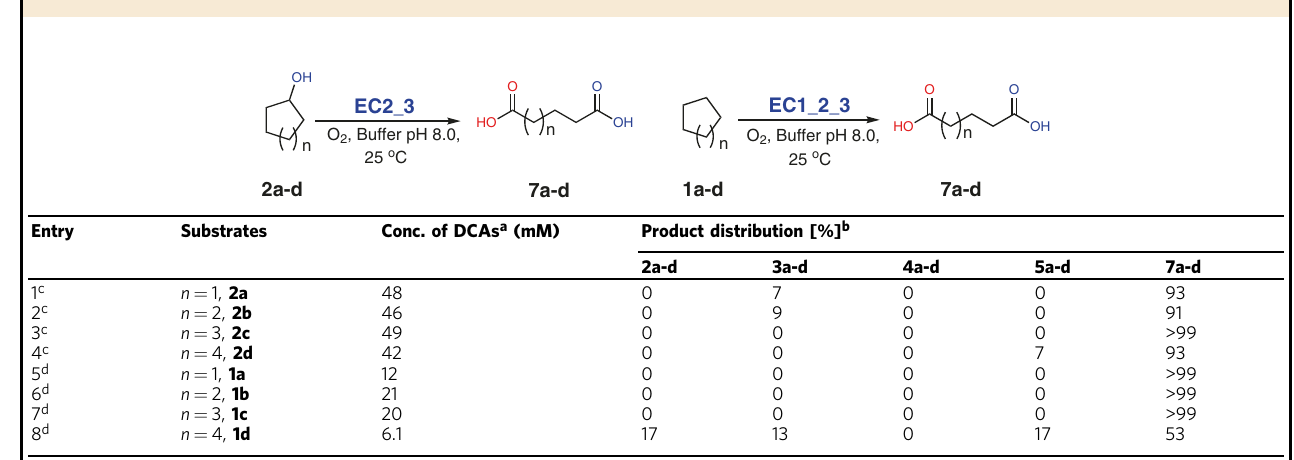
Table 1 One-pot DCAs production with designed E. coli consortia.